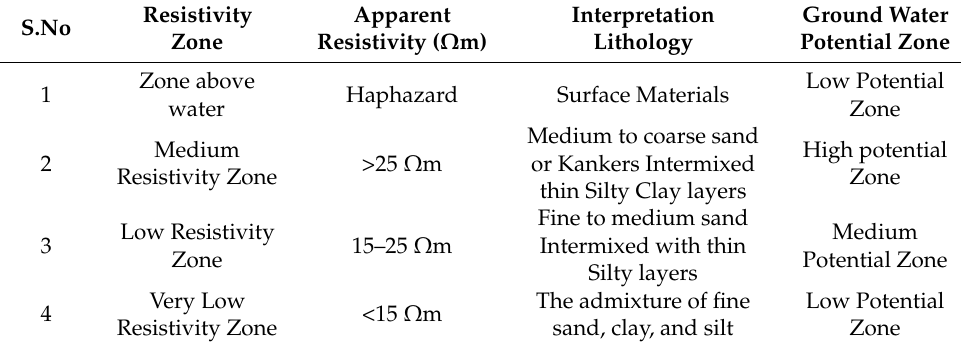
Table 3. Resistivity values versus lithology modified after